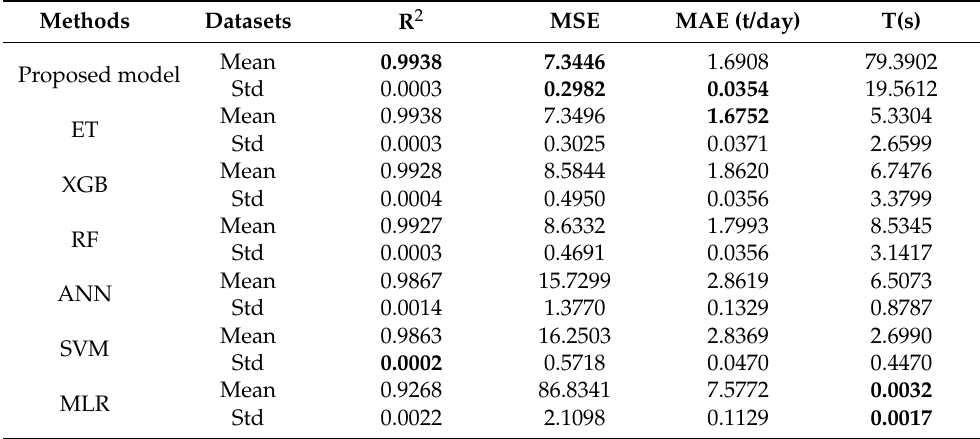
Table 6. Mean and Standard deviation(Std) of different model error